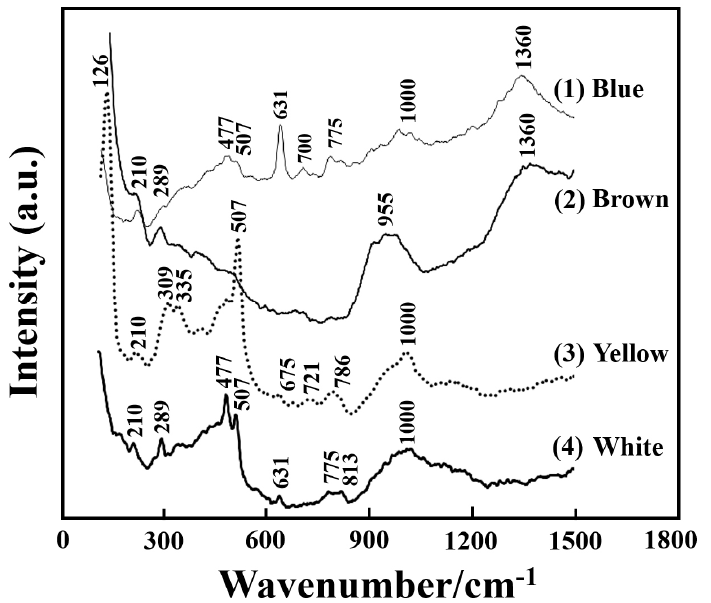
Figure 6. Raman spectroscopy of glaze coating and pigments: blue pigment on top of white matrix (tile no. 334, Type A, graph 1); glaze matrix with brown pigment of tile no. 328 (Type B, graph 2); yellow pigment on top of white matrix (tile no. 334, Type A, graph 3); and white glaze matrix of tile no. 334 (Type A, graph 4).